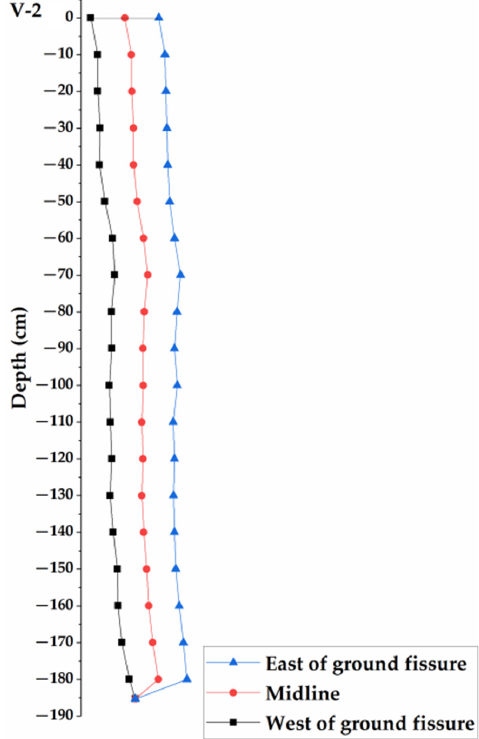
Figure 10. The ground fissure morphology of V-2.